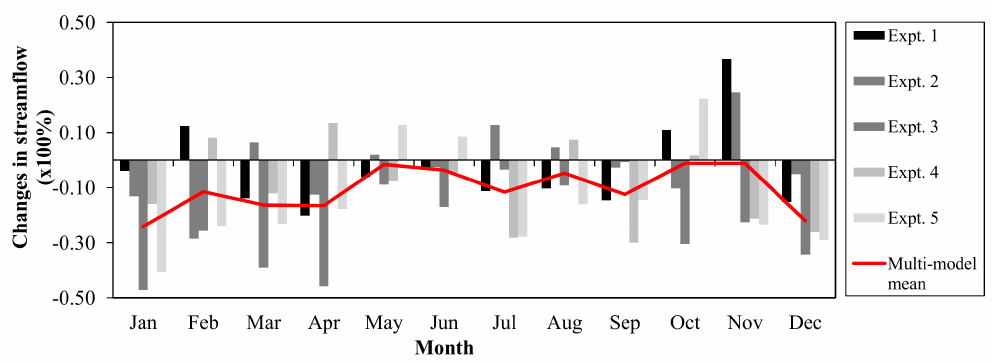
Figure 9. Changes in average monthly streamflow in the near-term (2026–2035) climate simulated using projected rainfall, relative to the baseline (1979–2008)